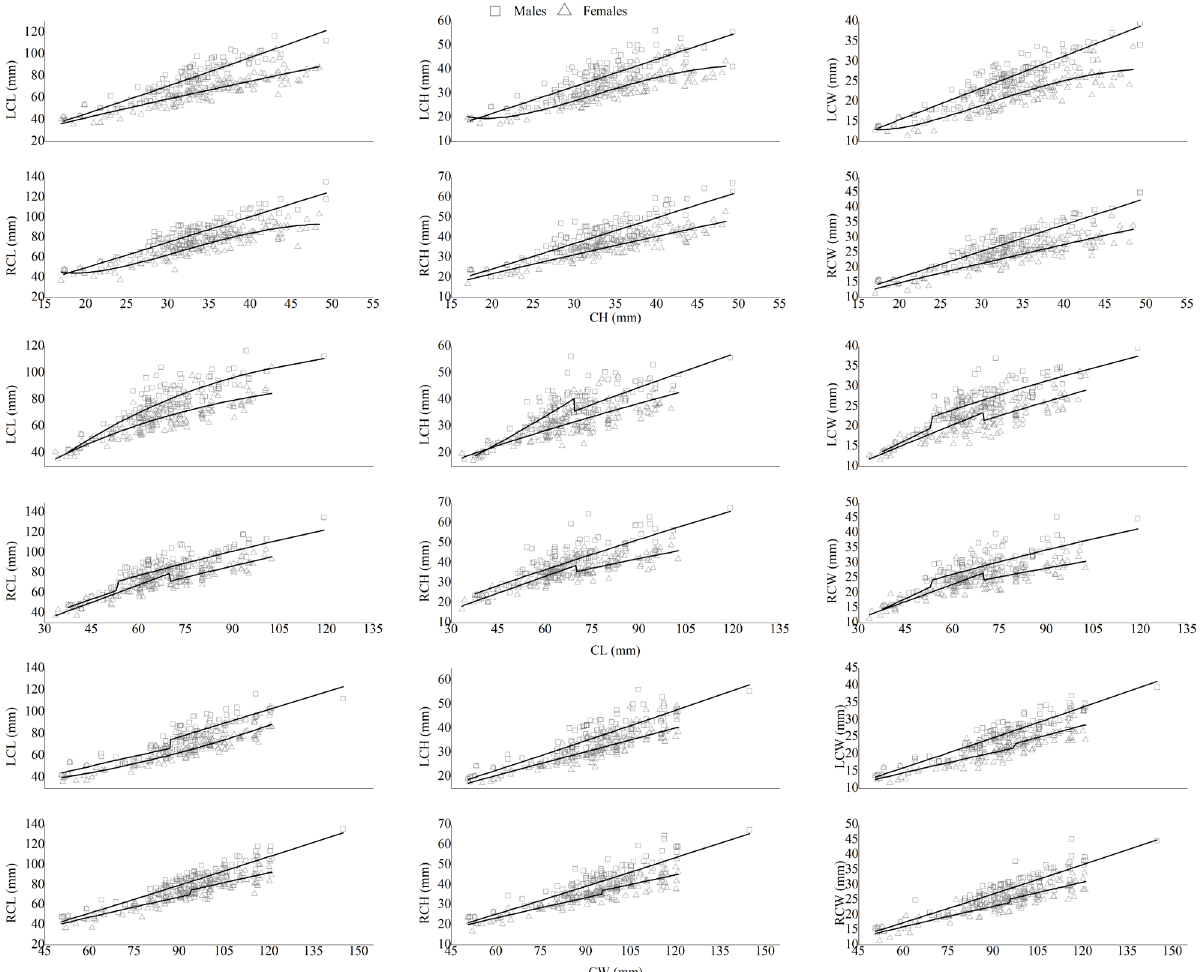
Figure 3. Raw data and the best models fitted to each morphometric relationship established for Menippe frontalis in the Gulf of Guayaquil, Ecuador. CW, carapace width; CL, carapace length; CH, carapace height; LCL, left chelae length; LCH, left chelae height; LCW, left chelae width; RCL, right chelae length; RCH, right chelae height; RCW, right chelae